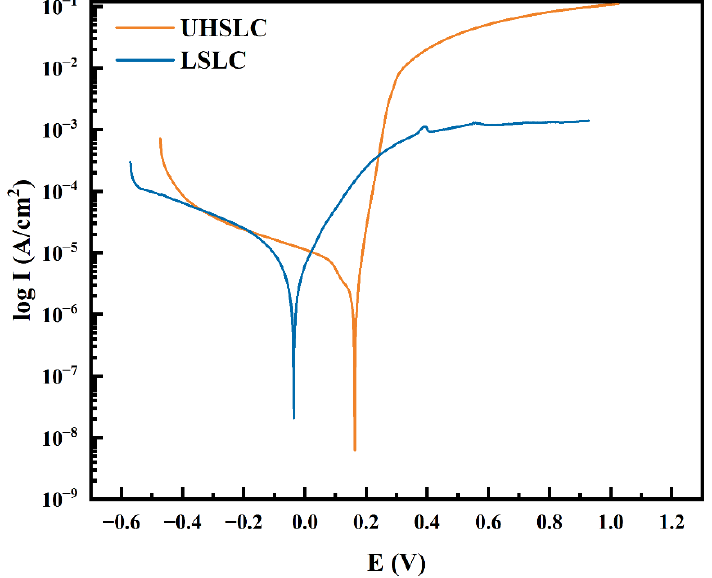
Figure 13. The wear mass loss of Inconel625 alloys coatings prepared by UHSLC and LSLC.